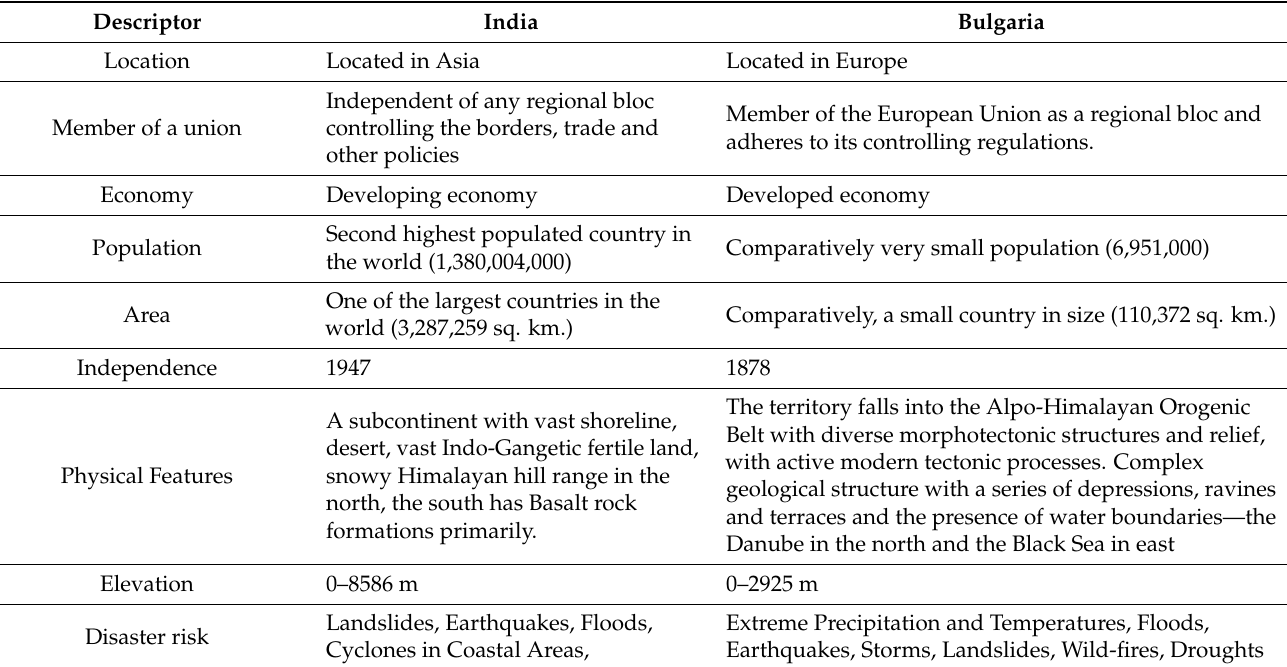
Table 2. Characteristics of India and